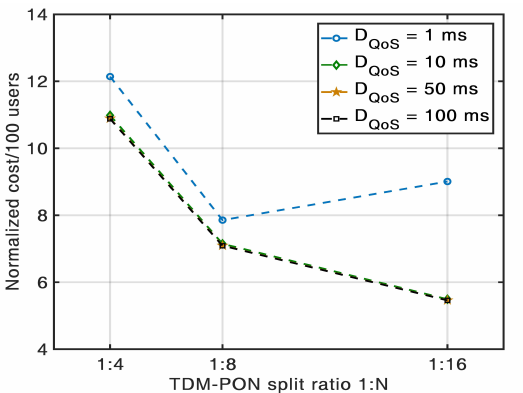
Figure 8. Variation of normalized cloudlet deployment cost/100 users against TDM-PON split-ratio 1 : N for a circular area with diameter = 4 km and population density = 4000 people/km 2 .